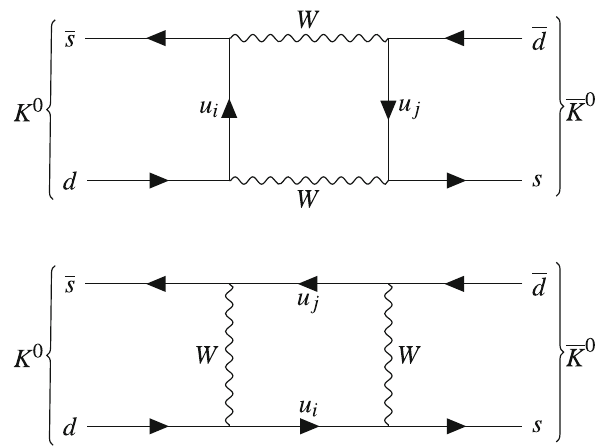
Fig. 1 Leading contributions to K 0 − K 0 mixing, including the effect of the new heavy quark, with u i = u , c , t , T